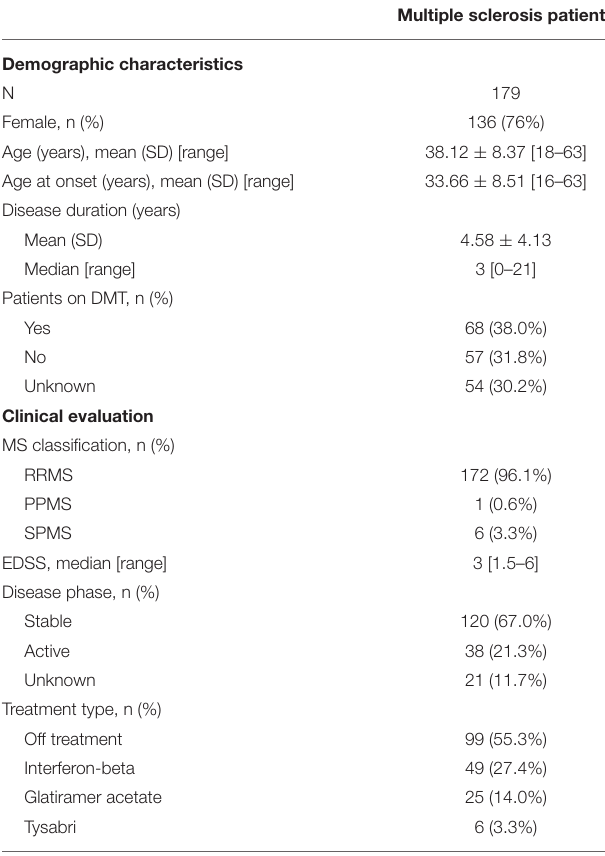
TABLE 1 | Demographic and clinical characteristics patient cohort.